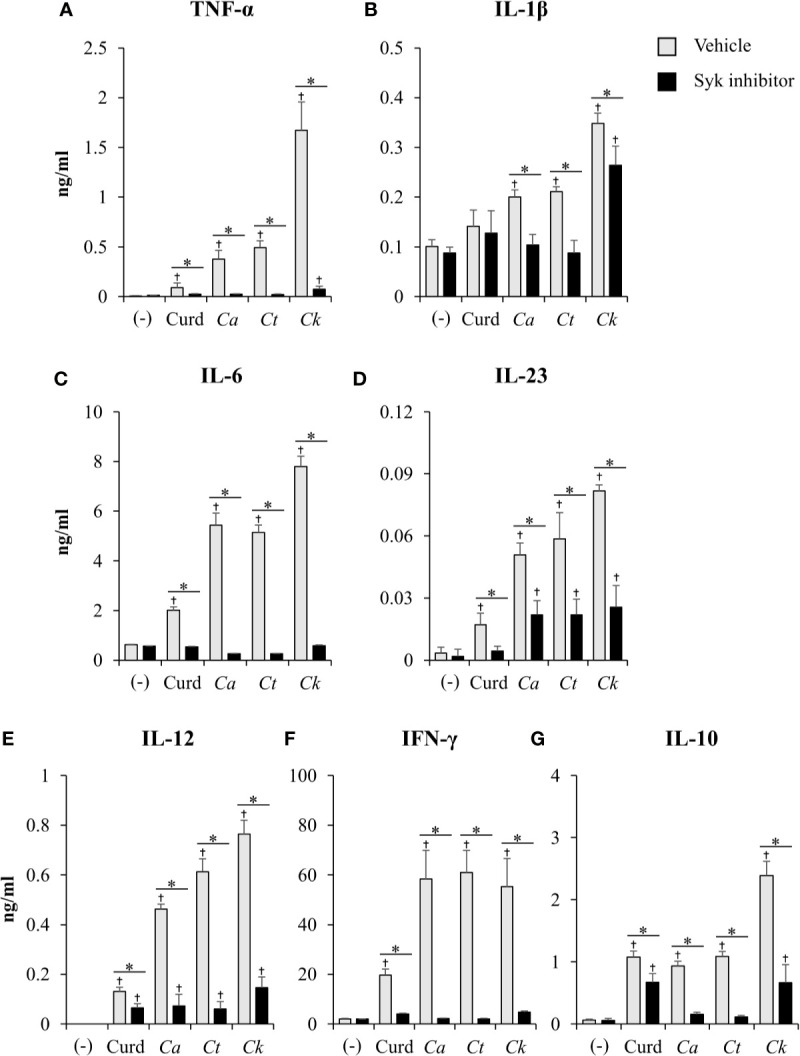
Effects of Syk inhibition on dendritic cell (DC) cytokine production. Bone-marrow derived DCs (BMDCs) were pre-treated with 1 µM of Syk inhibitor for 30 min, and then the cells were stimulated with 25 µg/ml of curdlan and β-glucans isolated from C. albicans, C. tropicalis, and C. krusei for 48 h. Levels of (A) TNF-α, (B) IL-1β, (C) IL-6, (D) IL-23, (E) IL-12, (F) IFN-γ, and (G) IL-10 were measured in culture supernatants by ELISA. n = 5; data are representative of two independent experiments. †
p < 0.05 compared with unstimulated BMDCs, *p < 0.05. (-), unstimulated BMDCs; Curd, curdlan; Ca, C. albicans; Ct, C. tropicalis; Ck, C. krusei.